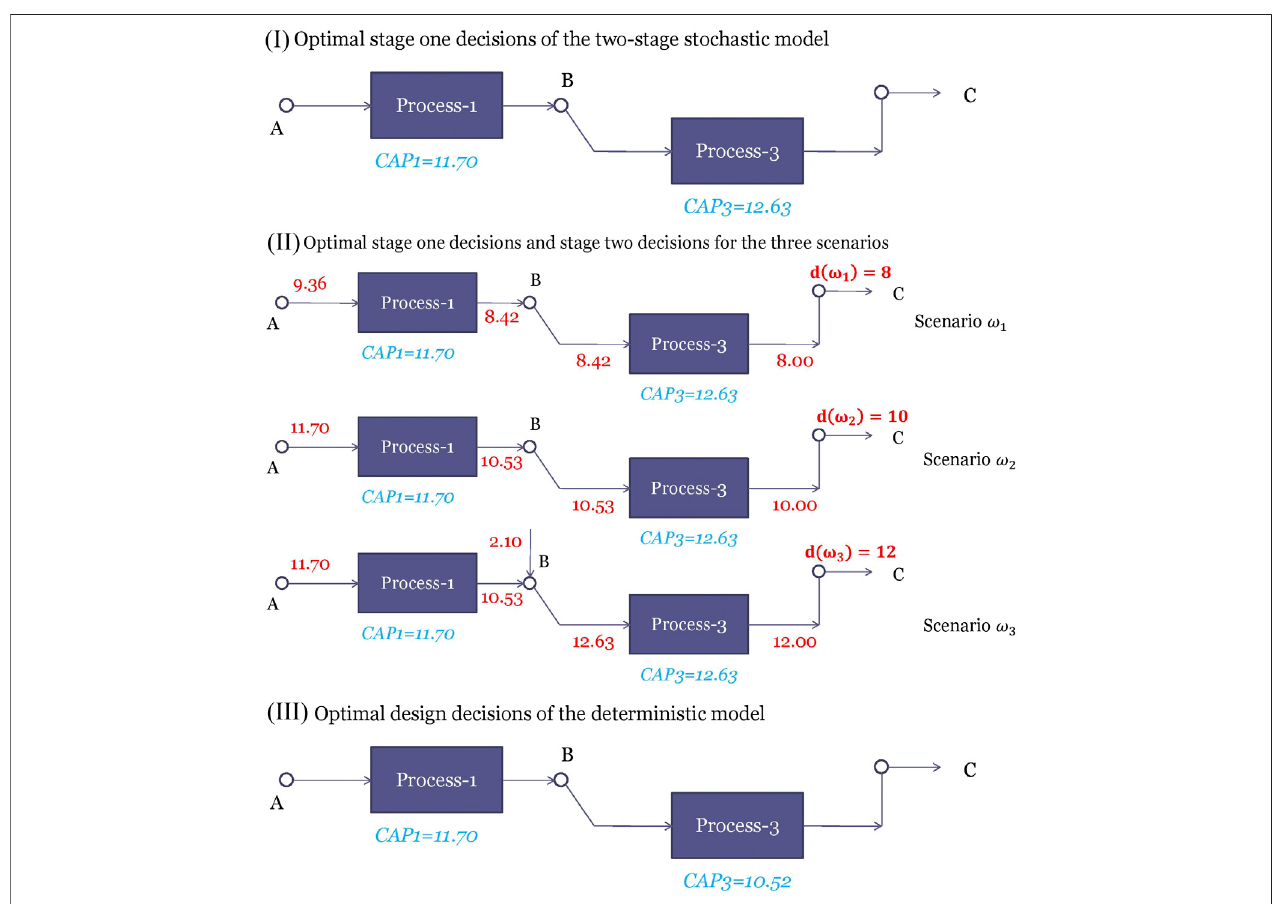
FIGURE 4 | (I) represents the optimal fi rst stage decisions of the two stage stochastic program (II) describes the optimal stage one decisions and the stage two decisions under scenarios ω 1 , ω 2 , ω 3 (III) represents the optimal design decisions of the deterministic